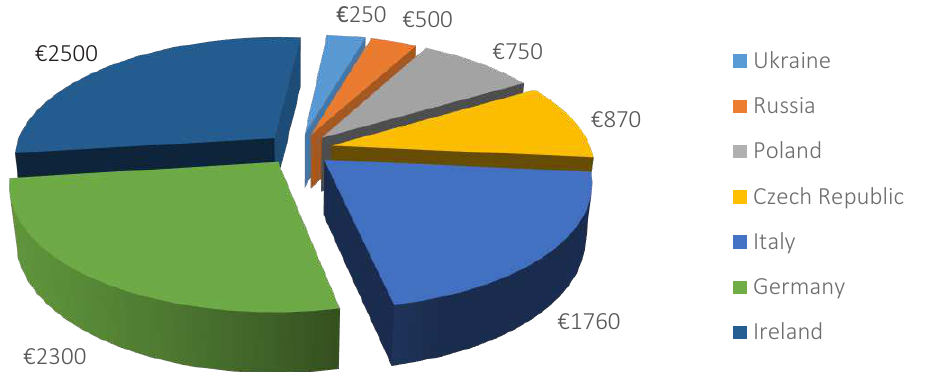
Figure 1. Average salaries in some European countries